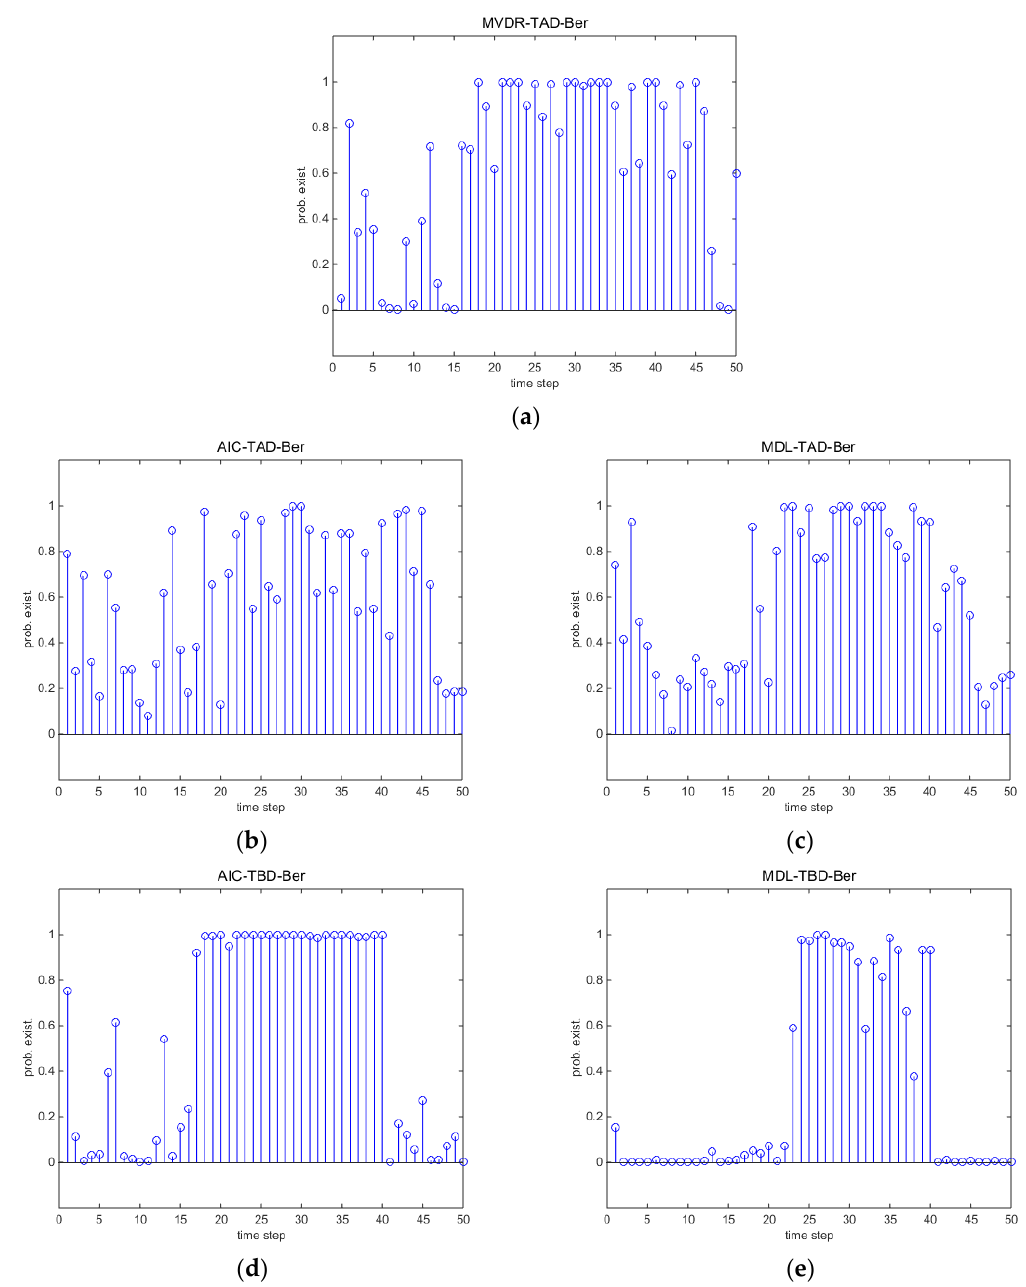
Figure 5. Detection results with SNR = −14 dB and snapshots 𝑁 = 200 . ( a ) MVDR-TAD-Ber; ( b ) AIC-TAD-Ber; ( c ) MDL-TAD-Ber; ( d ) AIC-TBD-Ber; ( e ) MDL-TBD-Ber.